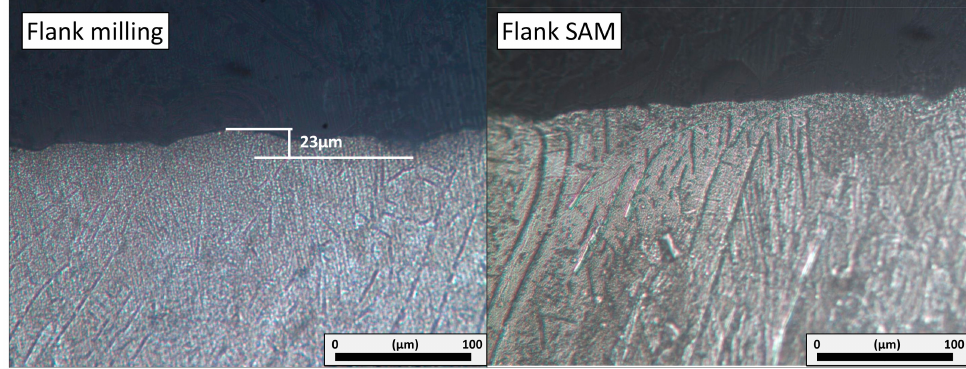
Figure 6. Cross-section of the Inconel ® 718 surface after flank milling and flank